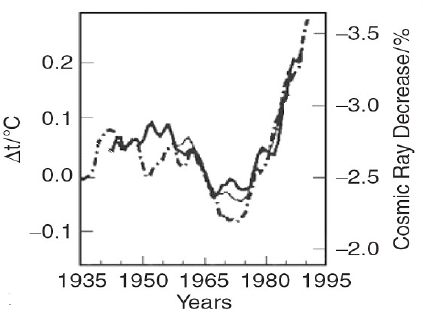
Fig. 4. Eleven year average Northern Hemisphere marine and land air temperature variation 1t (broken curve), compared with eleven year average CR intensity: thick solid curve – from data of Comp- ton type ionization chambers shielded by 10cmPb (1937–1994, normalized to 1965), and thin solid curve – from Climax neutron monitor (normalized to ion chambers, 1953–1994). According to Svensmark